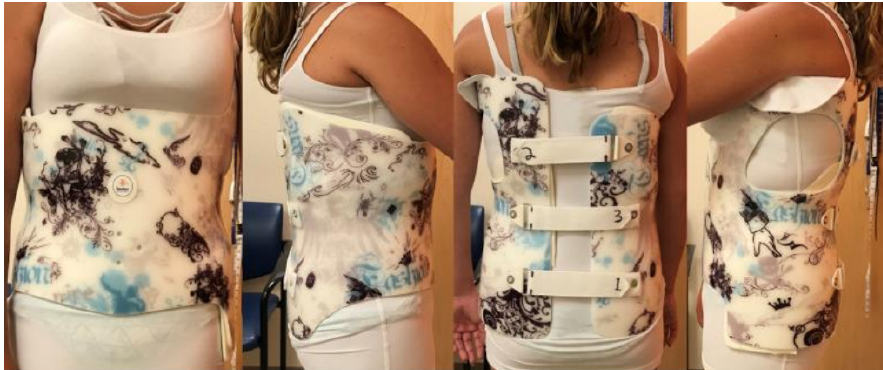
Figure 1. Four views of the Boston Brace 3D.